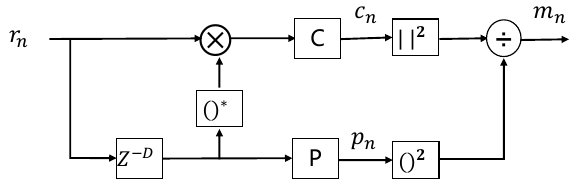
Figure 9. Auto-correlation algorithm.